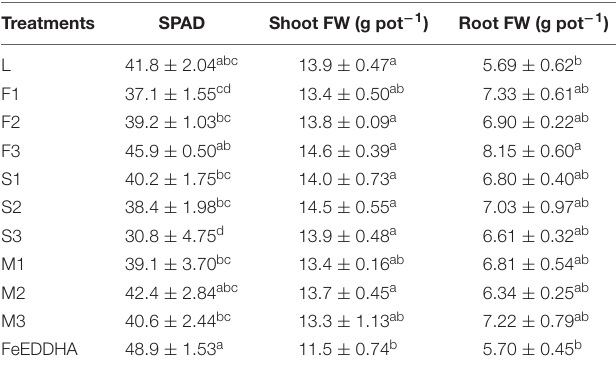
TABLE 3 | SPAD index at the last level of trifoliate well developed soybean leaves and fresh weight (FW) of shoots and roots of soybean control (L) plants and plants fertilized with the 57 Fe products F, S, and M in three doses: (1) 35, (2) 75, and (3) 150 µ mol 57 Fe pot − 1 or 50 µ mol 57 FeEDDHA pot − 1 at 48